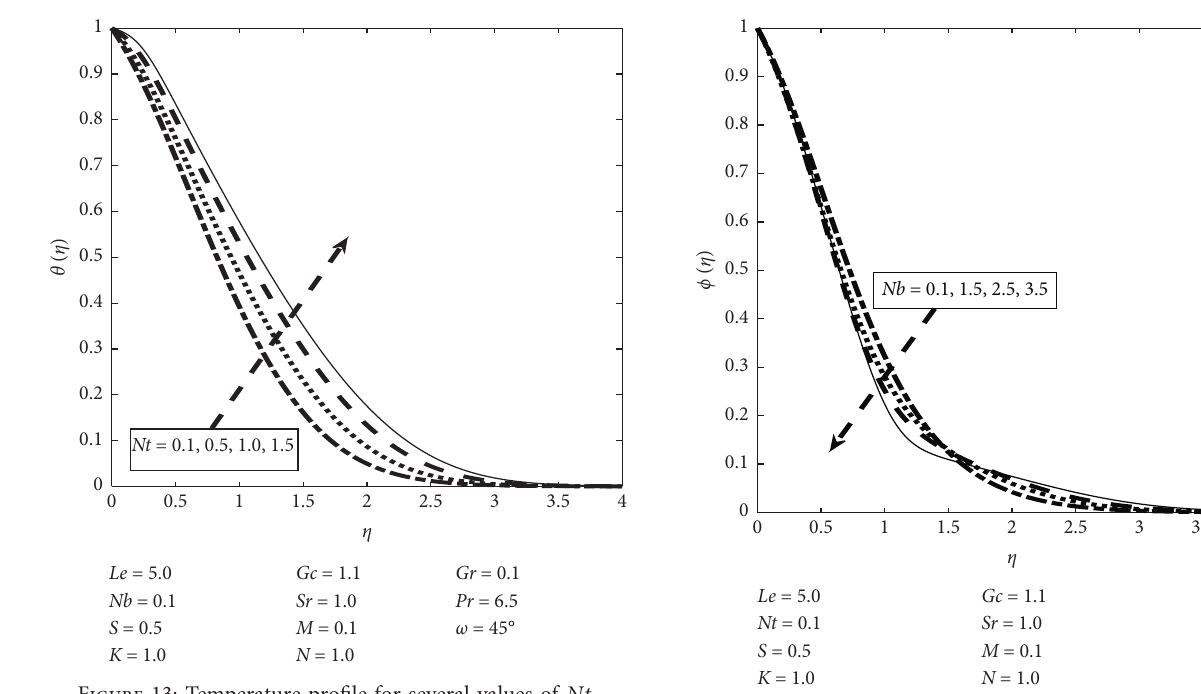
Figure 15: Concentration profile for several values of Nb .